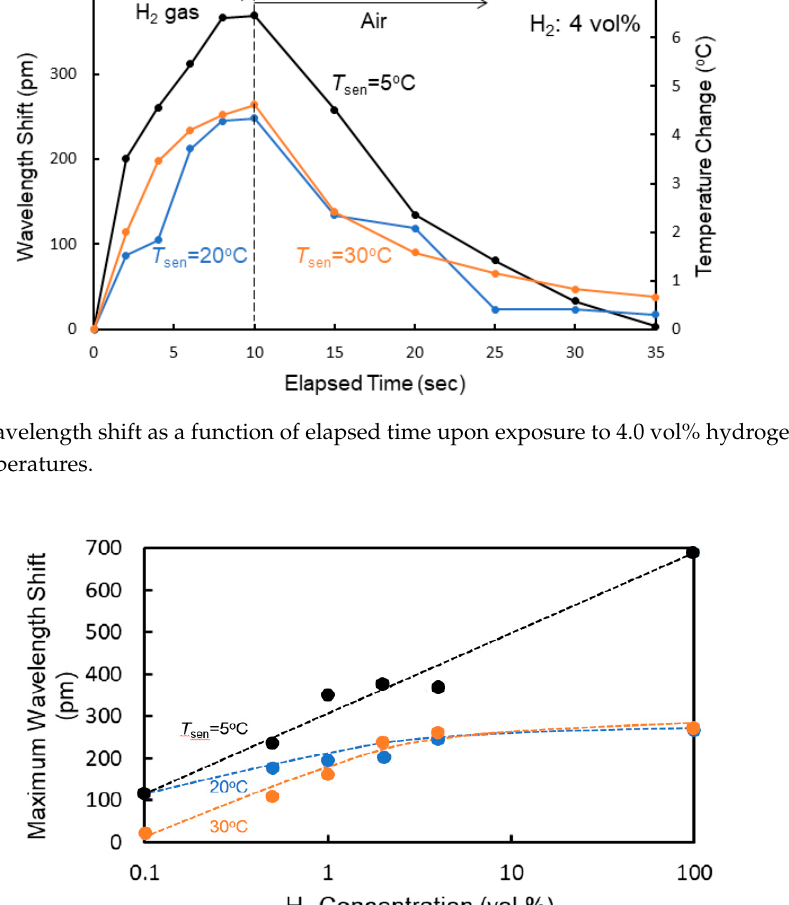
Figure 12. Relationship between the evaluated thickness of the H x WO 3 layer on the surface side and hydrogen concentration of gas to which the sensor is exposed.